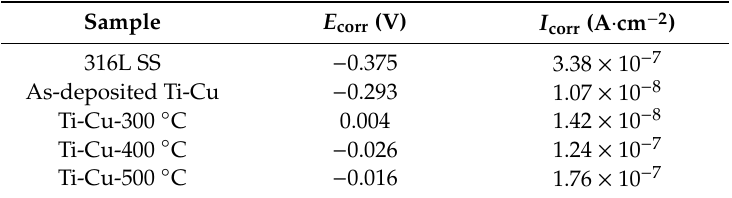
Table 2. The corrosion potential ( E corr ) and current densities ( I corr ) of 316L SS and Ti–Cu coatings before and after annealing at 300 ◦ C, 400 ◦ C, and 500 ◦